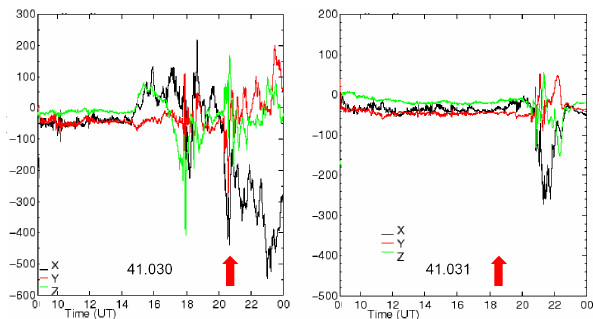
Fig. 11. Magnetogram records for the launch times of Flights 41.030 (24 January 2003, 20:50 UT) and 41.031 (28 Jan- uary 2003, 18:32 UT) from Esrange, Sweden.